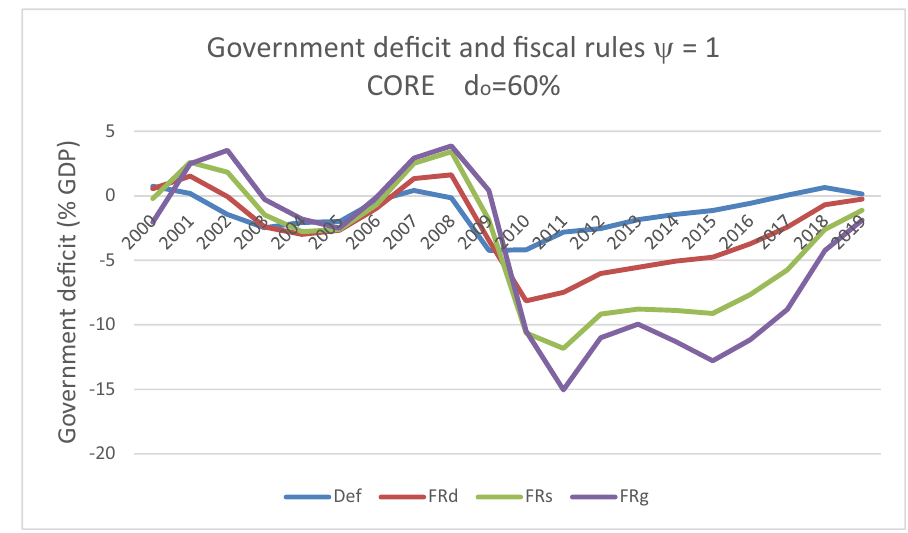
Figure 1.2: CORE countries government de fi cit ψ = 1 ( Source: Own elaboration from data on Table 1 ) .